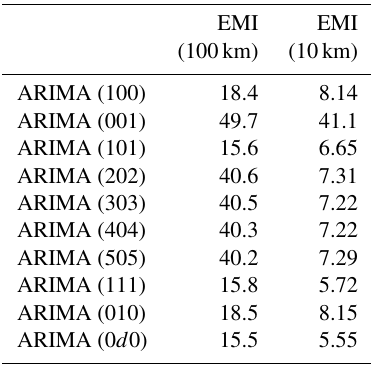
Table 1. Comparison of residuals (RMSE) of each ARIMA model for the 100 and 10km EMI